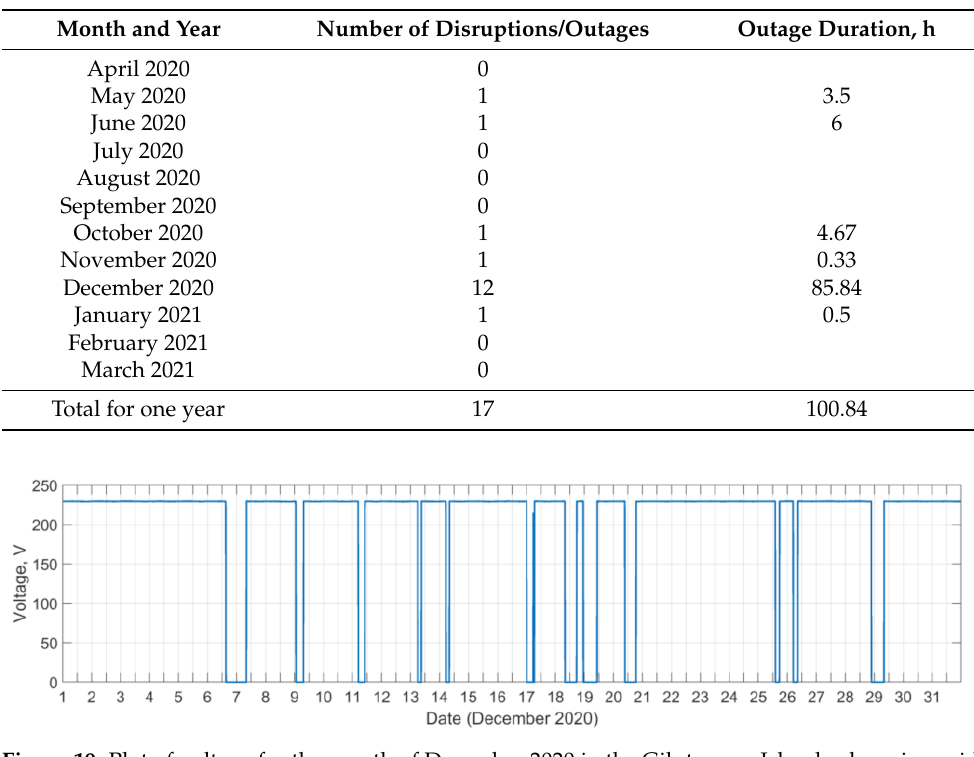
Figure 19. Plot of voltage for the month of December 2020 in the Gilutongan Island solar microgrid, showing unscheduled outages due to rainy days, in turn necessitating the addition of battery energy storage